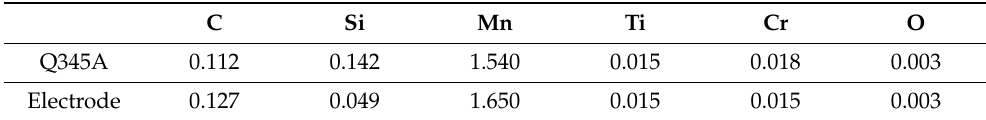
Table 4. Measured chemical compositions of the BM and electrode